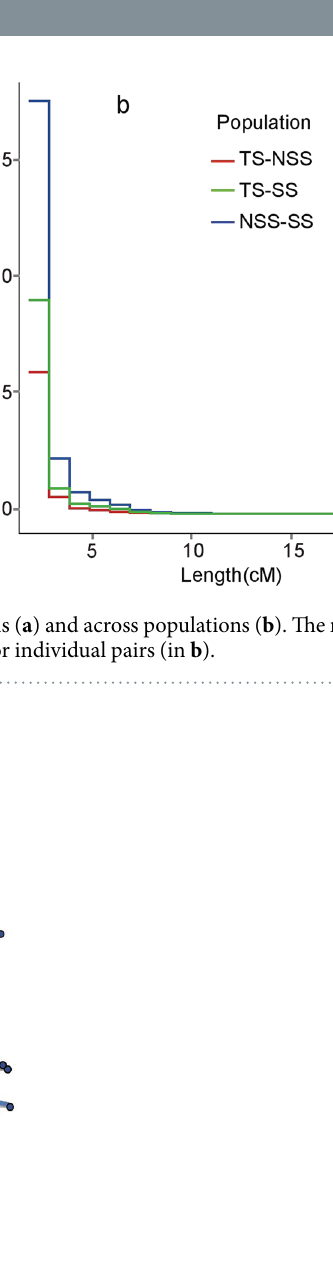
(Fig. 5). Based on the random expectation, the chance of two 19th descendants sharing a 7 cM IBD block is very slim; therefore, we used 7 cM as a threshold to define small and long IBD blocks. We plotted short IBD blocks ( < 7 cM), which are universal among all inbred lines (grey lines in Fig. 5) and long IBD blocks ( > 7 cM), which tend to be concentrated in a few lines. Of particular interest is the finding that IBD sharing not only occurs between closely related lines but also between distantly related lines. The distribution of IBD blocks across the genome is also imbalanced. Regions with extensive IBD sharing are indicative of regions under positive selection during domestication or improvement. The average frequency of IBD segments spanning each 10 cM window are displayed in Fig. 6. Of the IBD regions with the highest frequency (top 5%), 10.7% and 9.7% of IBD overlap with regions that were previously predicted to be under selection during maize domestication and improvement 6 , respectively. This overlap is greater than expected by chance (P < 0.03,